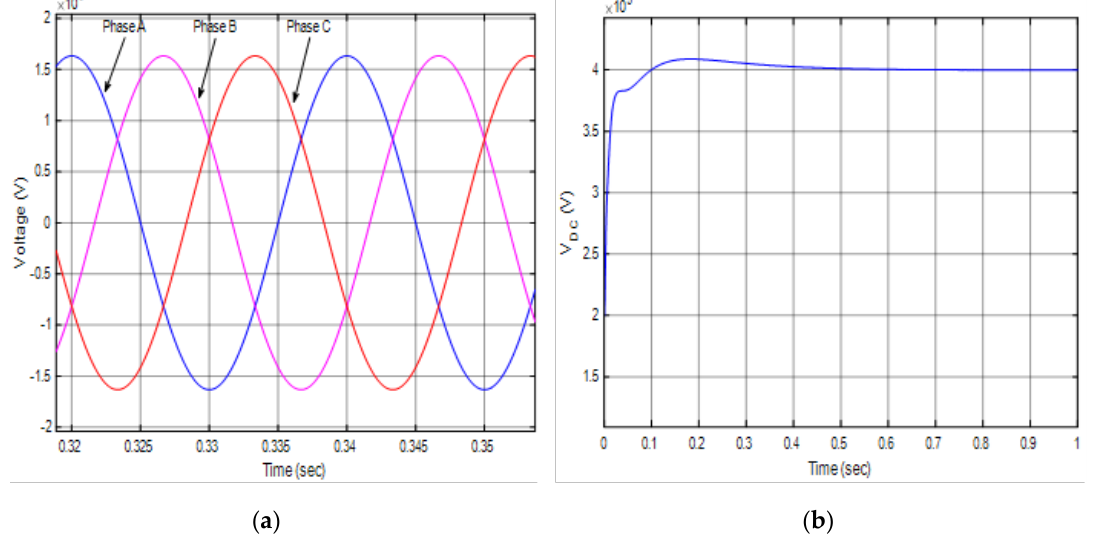
Figure 5. VSC terminal-I voltages; ( a ) AC grid voltage, ( b ) DC-voltage.